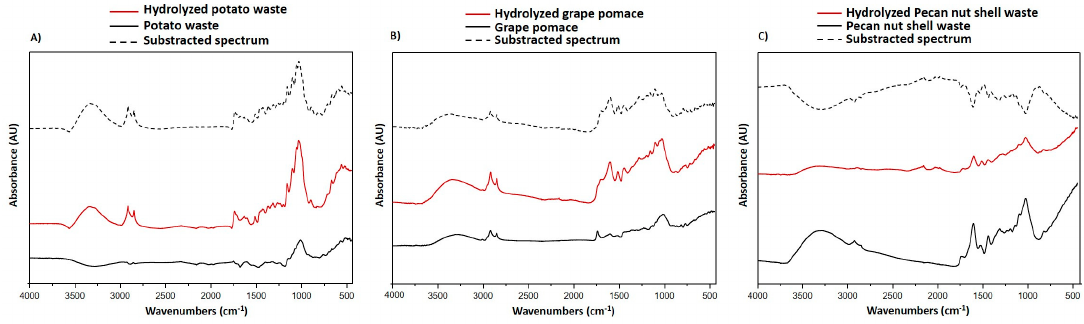
Figure 9. ATR-FTIR spectra of ( A ) potato waste, ( B ) grape pomace and ( C ) pecan nut shell.